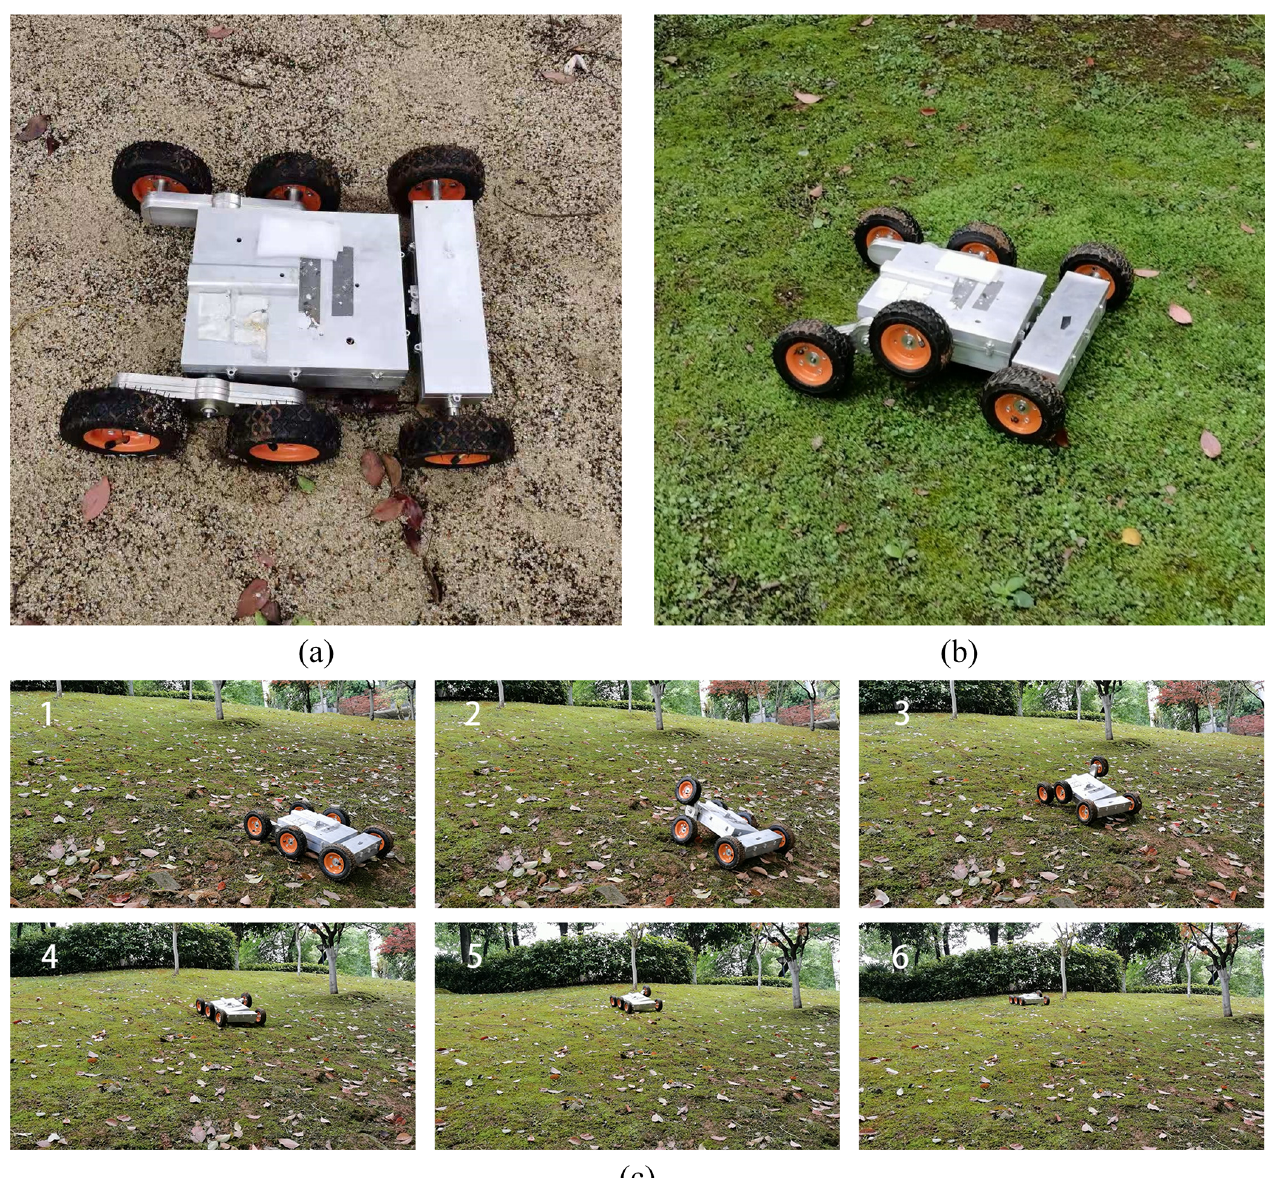
Figure 21. The experiment of the robot movement on sand, grass, and slopes